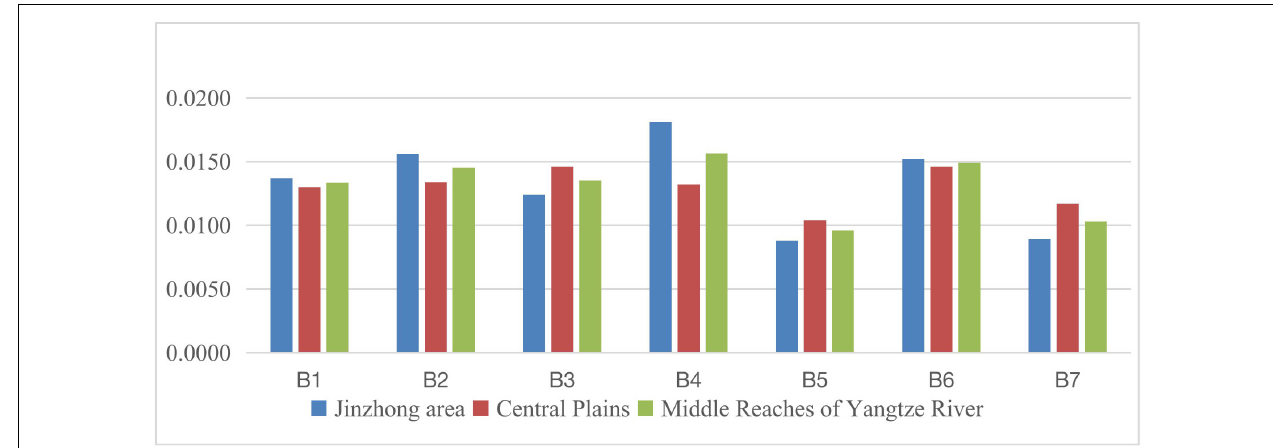
FIGURE 5 | Social development level of each indicator within the middle region during 2011–2015.